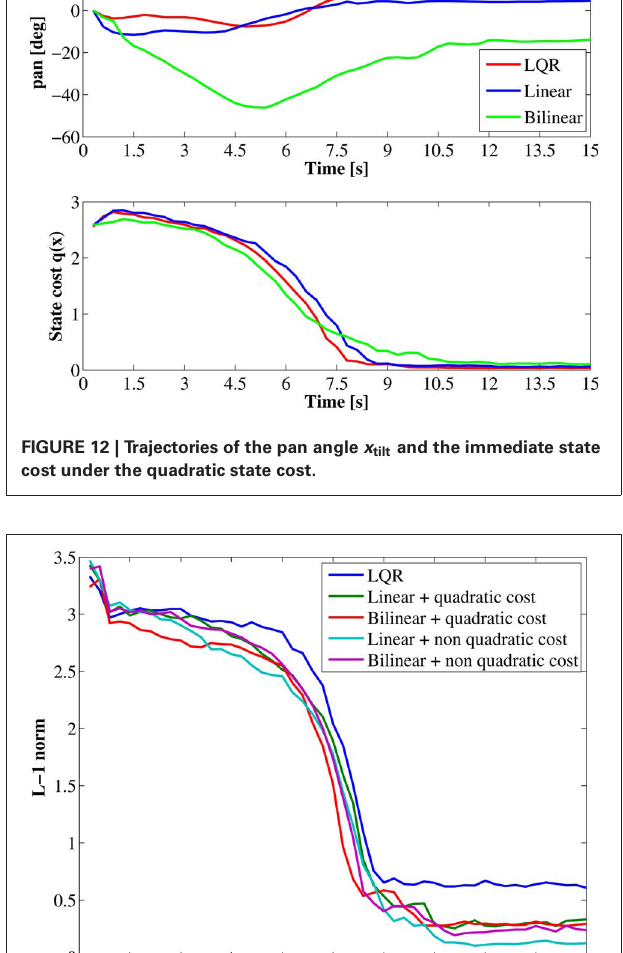
As discussed in section 3, the quality of obtained control policy depends on the accuracy of the estimated environmental